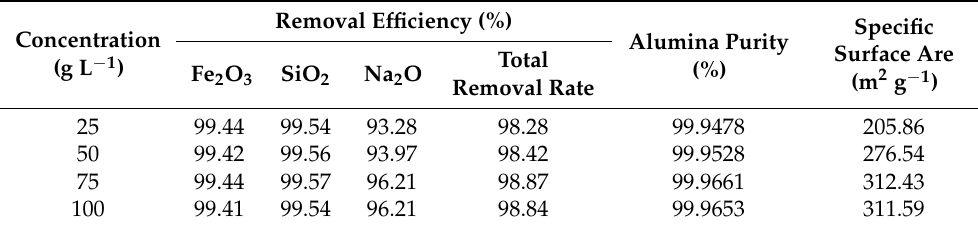
Table 7. Effect of mass concentration of ammonium carbonate solution on impurity removal efficiency, specific surface area and alumina